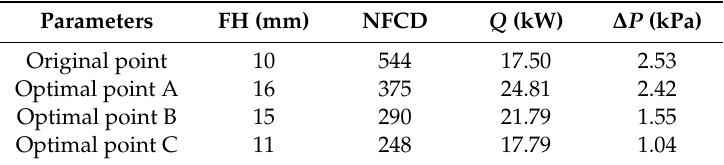
Table 3. Optimization performances comparison of AR.